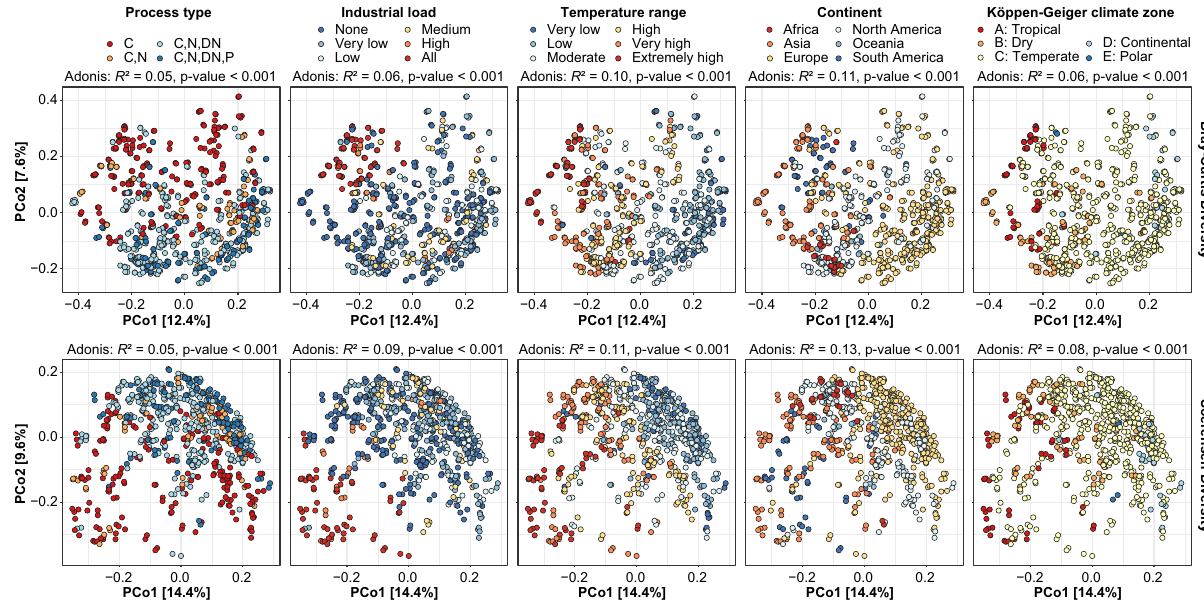
Fig. 5 Effects of process and environmental factors on the activated sludge microbial community structure. Principal coordinate analyses of Bray – Curtis and Soerensen beta-diversity for genera based on V1 – V3 amplicon data. Samples are coloured based on metadata. The fraction of variation in the microbial community explained by each variable in isolation was determined by PERMANOVA (Adonis R 2 -values). Exact P values <0.001 could not be con fi dently determined due to the permutational nature of the test. Process types: C carbon removal, C,N carbon removal with nitri fi cation, C,N,DN carbon removal with nitri fi cation and denitri fi cation, C,N,DN,P carbon removal with nitrogen removal and enhanced biological phosphorus removal (EBPR). Temperature range: Very low = <10 °C, low = 10 – 15 °C, moderate = 15 – 20 °C, high = 20 – 25 °C, very high = 25 – 30 °C, extremely high = >30 °C. Industrial load: None = 0%, very low = 0 – 10%, low = 10 – 30%, medium = 30 – 50%, high 50 – 100%, all = and Prevotella , the fi lamentous genera Sphaerotilus and Thiothrix , and the glycogen-accumulating organisms (GAOs) Ca . Compe- ( Rhodoferax , Sulfuritalea ) and the tibacter and De fl uviicoccus . Speci fi c to the EBPR plants were an polyphosphate-accumulating organisms (PAOs) ( Tetrasphaera , increased abundance of known PAOs (see above) and Azospira , Ca . Accumulibacter and Dechloromonas ) were strongly enriched Propionivibrio , Propioniciclava , Ca . Amarolinea and the de novo in more advanced process types along with de novo taxa taxa midas_g_399 (class: Actinobacteria), midas_g_384 (family: Saprospiraceae) and midas_g_945 (class: Elusimicrobia). The latter genera should be considered targets for further character- isation as potential PAOs or GAOs.